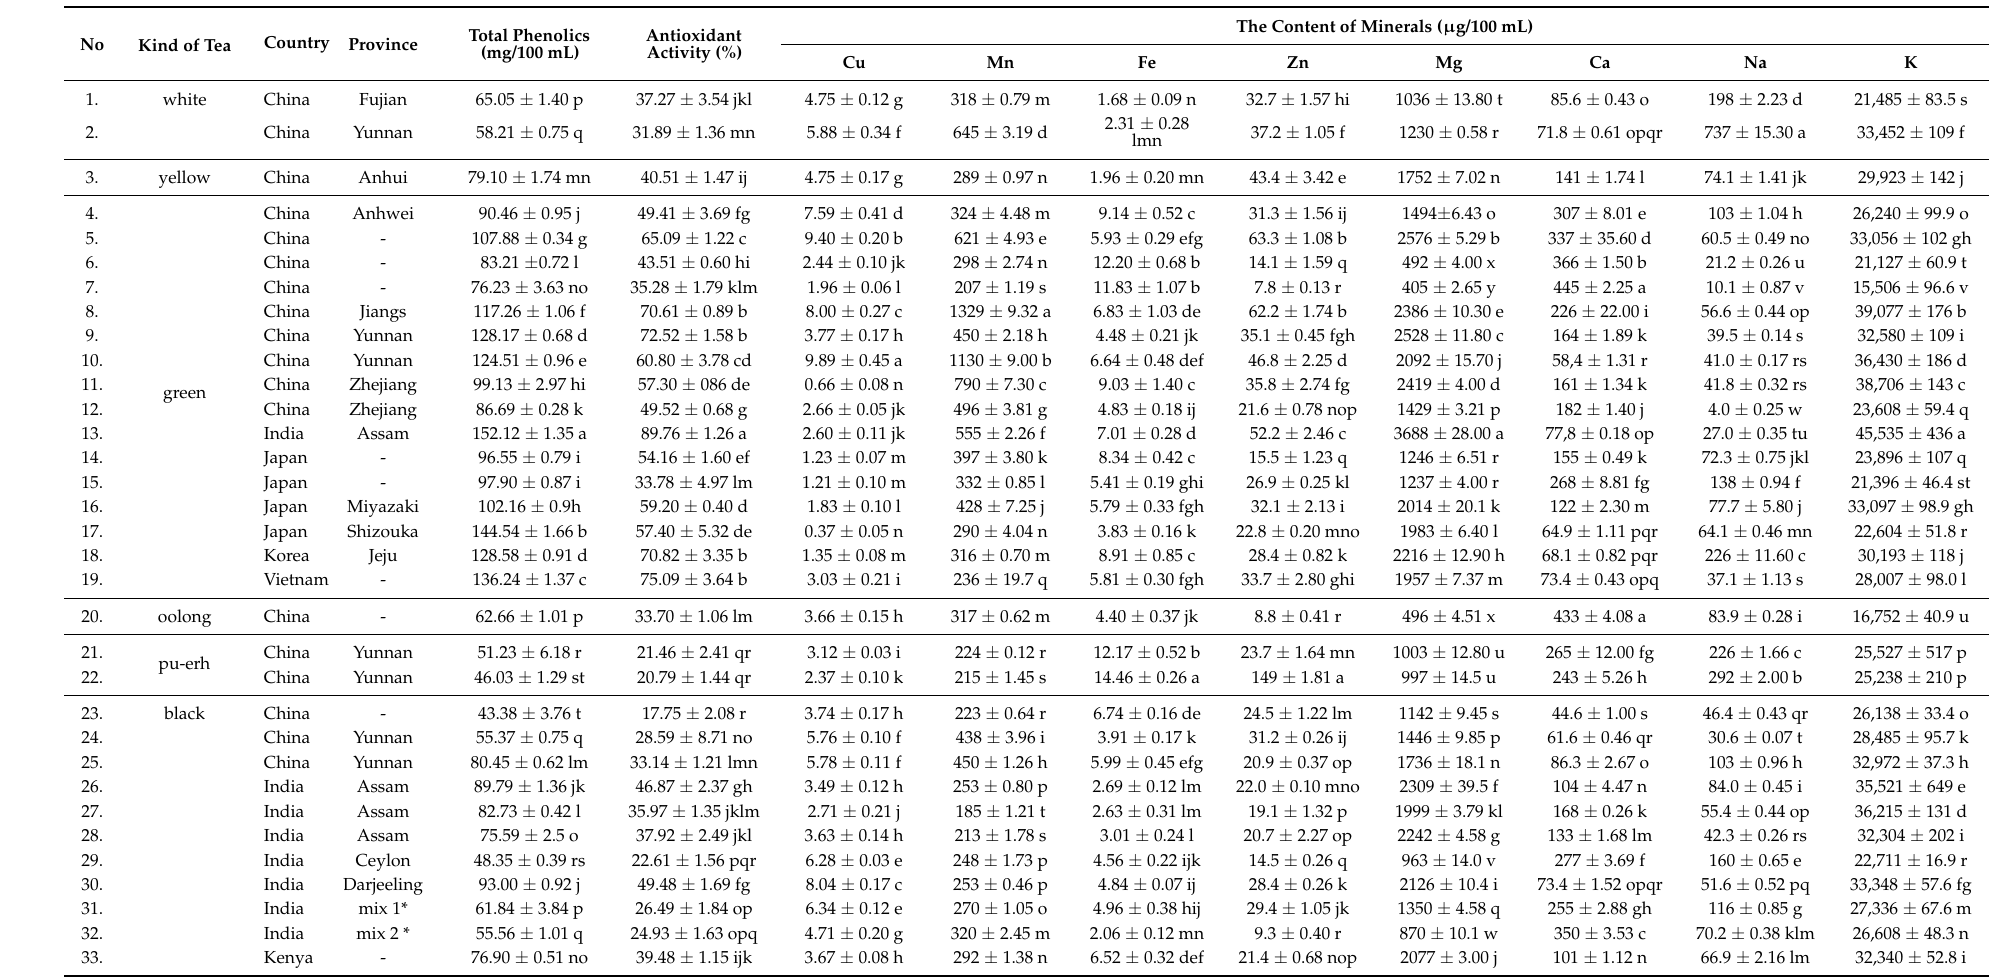
Table 1. The content of selected biologically active components determined in different tea